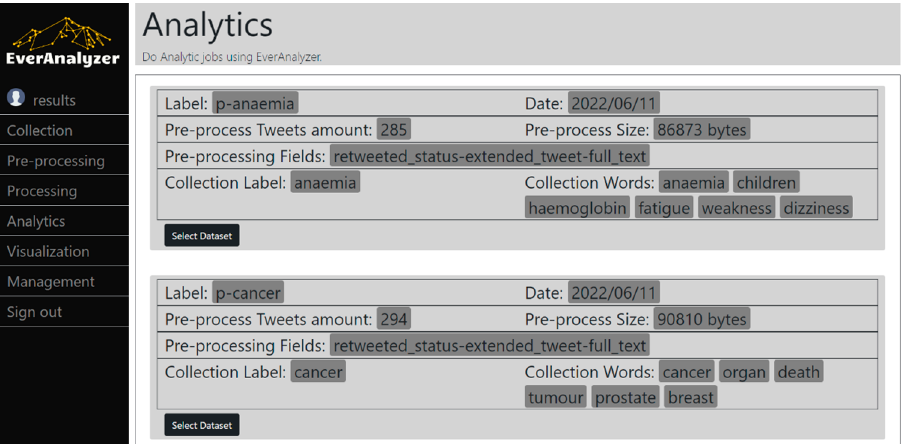
Figure 19. Analytics Interface—Pre-processing datasets.